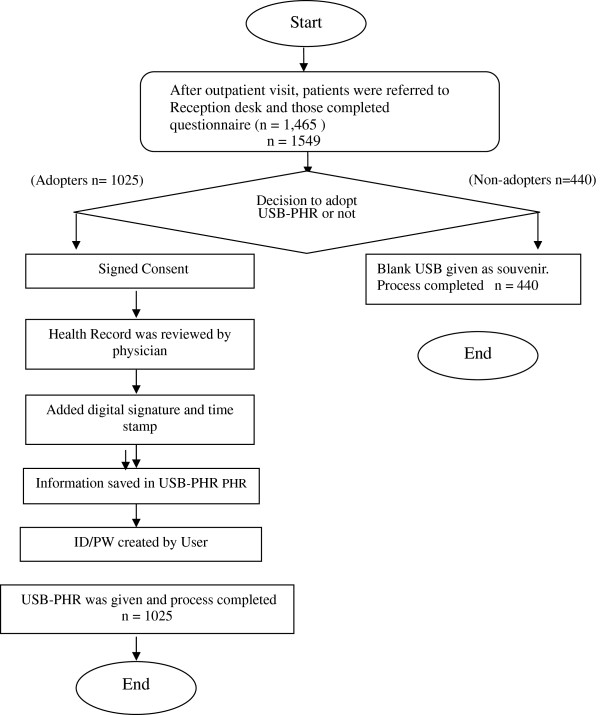
The study design.